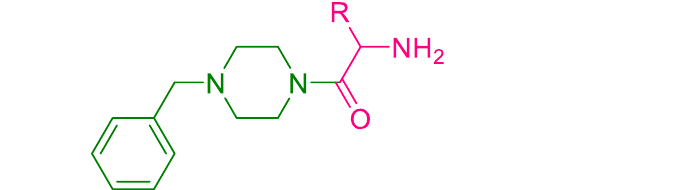
Figure 17. Amino acids conjugated to benzylpiperazine derivatives.